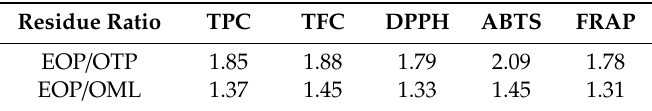
Table 5. Comparison of the main antioxidant activity indicators for EOP and other olive oil production